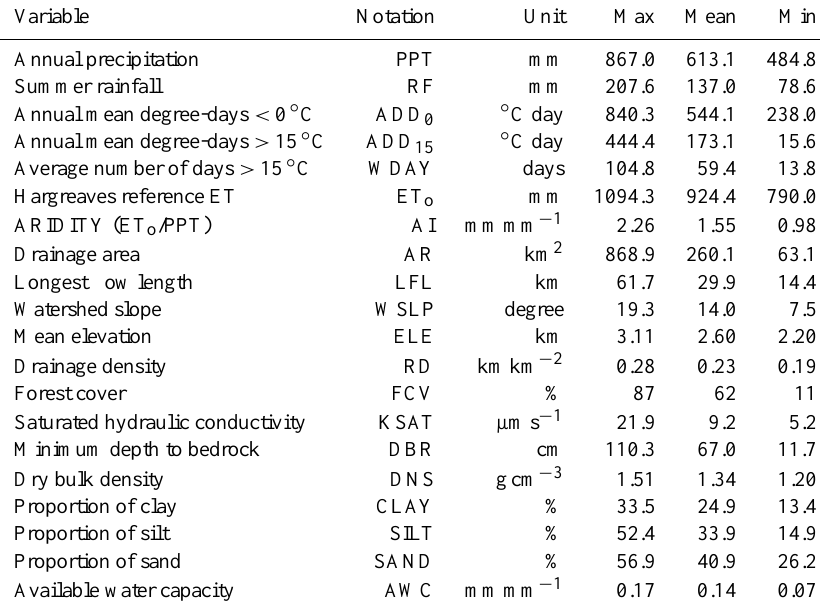
Table 4. Candidate variables for the multiple linear regression analysis.